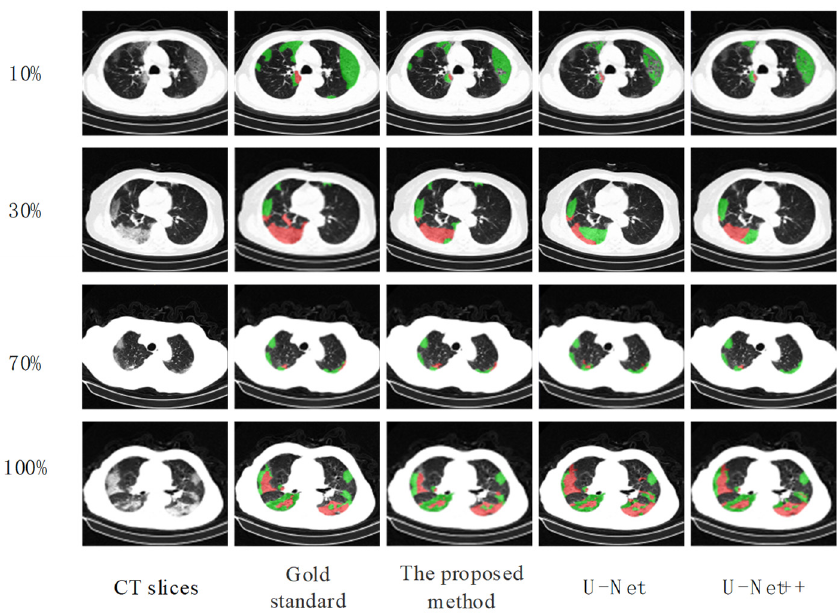
Figure 5. Comparison of Lesion Segmentation Results by Different Methods. Table 5. Comparison of Dice Coefficients for Different Enhanced Combinations. Crop